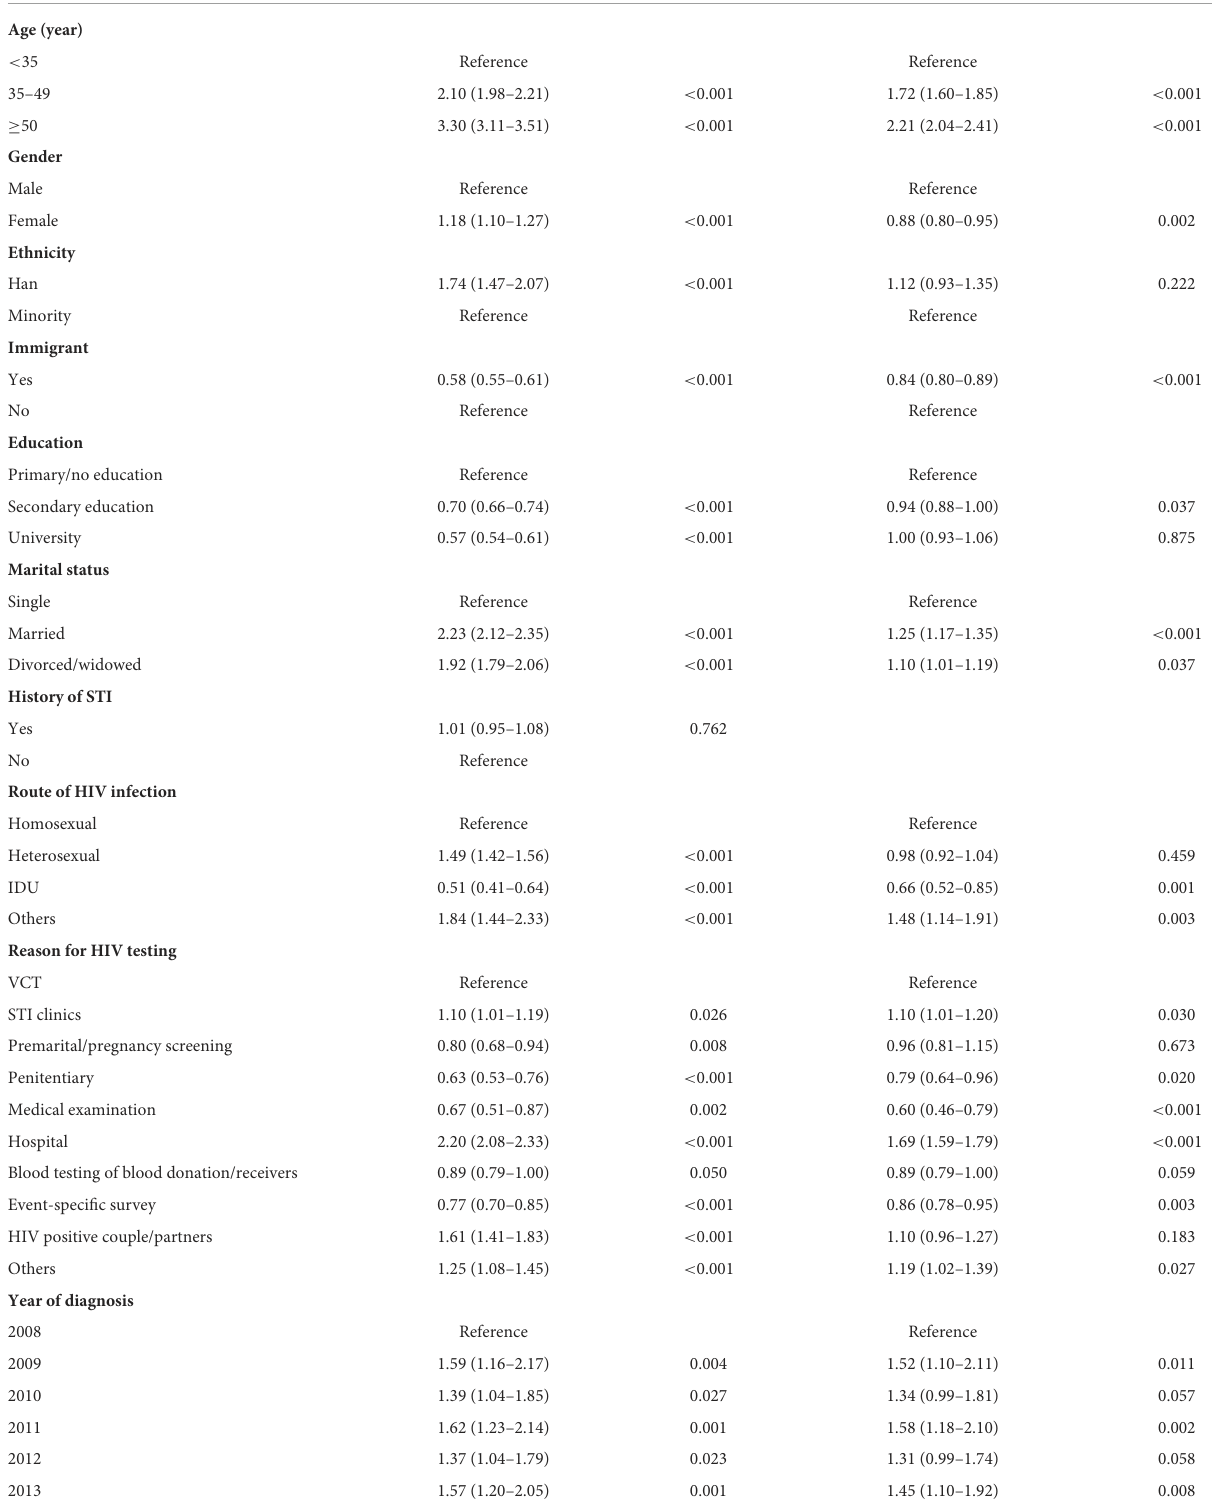
TABLE 2 Risk factors associated with late HIV presentation in Jiangsu province, China, 2008–2020. Characteristics of HIV